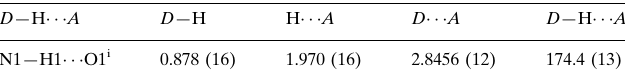
Hydrogen-bond geometry (A˚ , (cid:1)